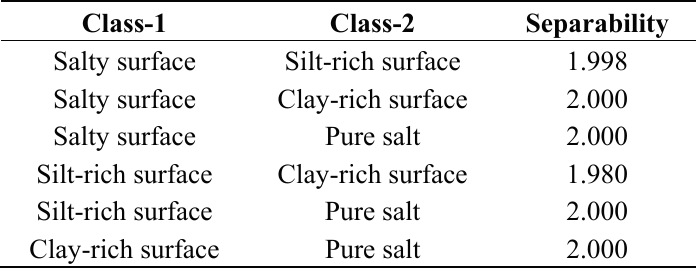
Table 3. Report of ROI separability for training pixels.